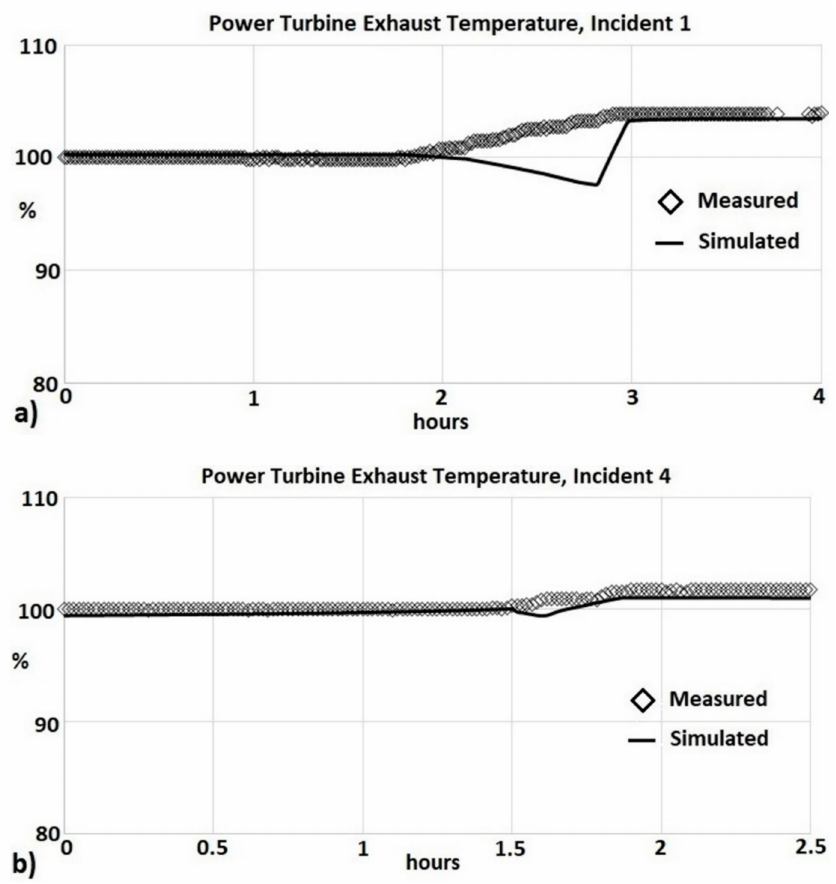
Figure 24. Measured and simulated exhaust temperatures: ( a ) Incident 1; ( b ) Incident